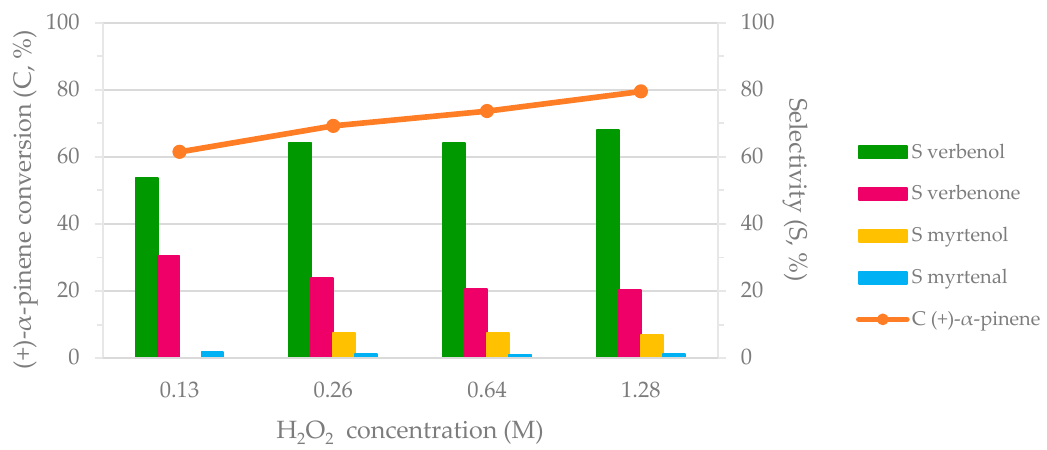
Figure 3. The influence of H 2 O 2 on the biocatalytic cascade system. Reaction conditions: 0.63 M (+)- α -pinene, 1.29 U/mL 2-1B peroxidase, 216 POU/mL M120 laccase, and H 2 O 2 in acetate buffer (0.1 M, pH = 5) for 24 h at 40 °C and 1000 rpm stirring rate.